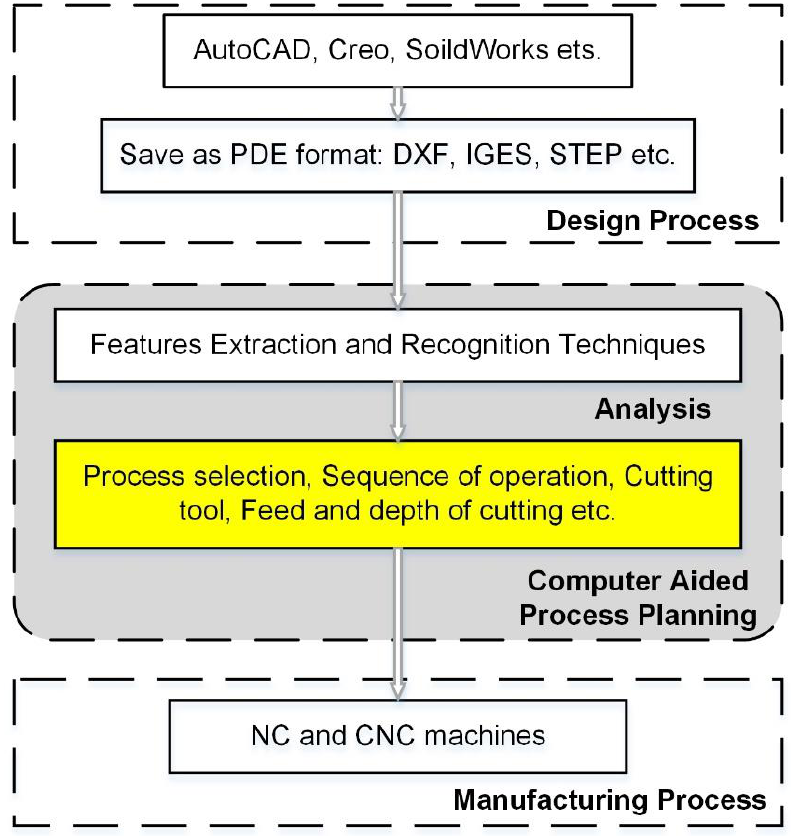
Figure 8. CAD/CAPP/CAM system integration [72].